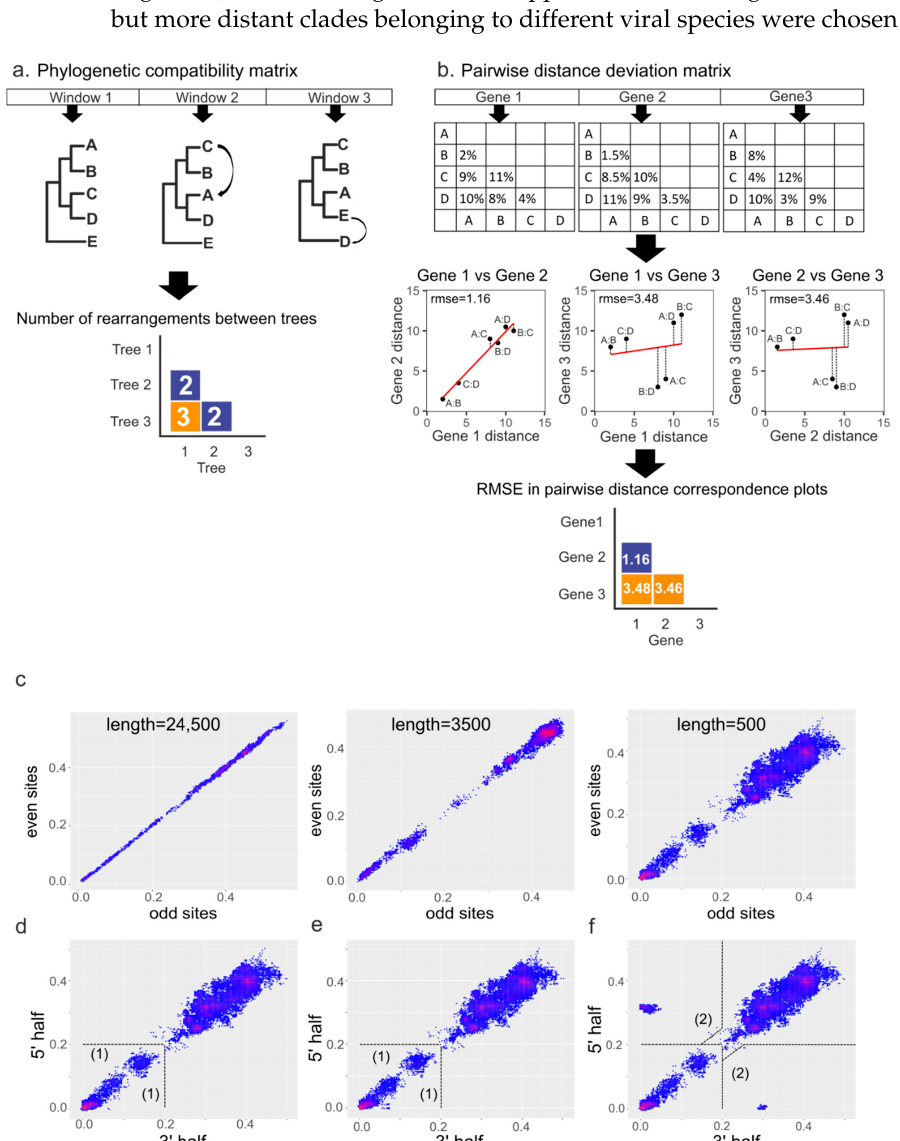
Figure 1. Principles of recombination detection methods. ( a ) illustration of compatibility matrix building algorithm [32,33]. For each window in the alignment, a phylogenetic tree is built, then the number of differences between obtained trees is calculated and stored in the matrix. The numbers of differences are usually normalized and visualized as a heatmap. ( b ) the algorithm for building pairwise distance correspondence plots (PDCP) and pairwise distance deviation (PDD) matrices. Pairwise genetic distances are calculated for genomic regions of interest. Then, each pair of sequence distances in genome region 1 and genome region 2 are plotted along the x and y axes, respectively, producing the PDCP. The overall divergence of all pairwise distances from the regression line is then estimated as the root-mean-square error (RMSE). RMSEs in plots for different genomic regions are visualized as a heatmap, making a PDD matrix. Simulated datasets were used to show typical PDCPs for alignments of different lengths without recombination ( c ), with one recombinant sequence in a 500-nt alignment ( d ), several recombination events between close clades ( e ), and recombination events between distant clades ( f ). Dotted lines indicate plot areas corresponding to recombination events between viruses differing by less than 20% nucleotide sequence in both genome regions (1), which were termed “recent”, and recombination events between viruses related by less than 20% in one genome region (2), termed “recent long-distance” for the purpose of discussion.